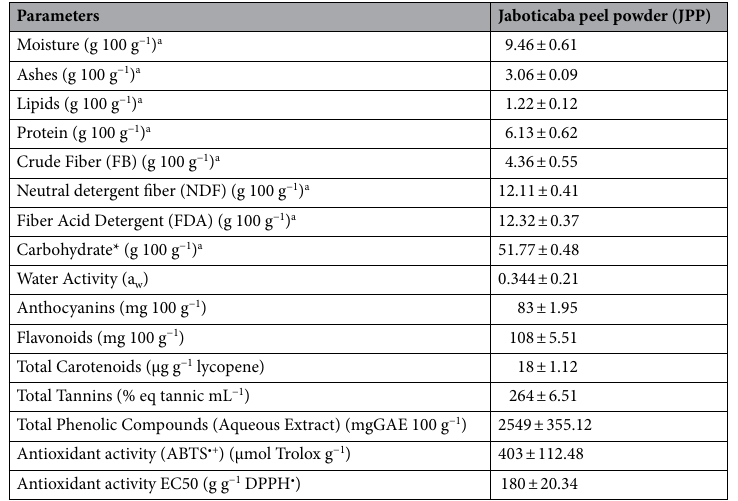
Table 1. Results of the centesimal, physicochemical and phytochemical characterization of the jaboticaba peel powder. a Dry basis.*Calculated by the